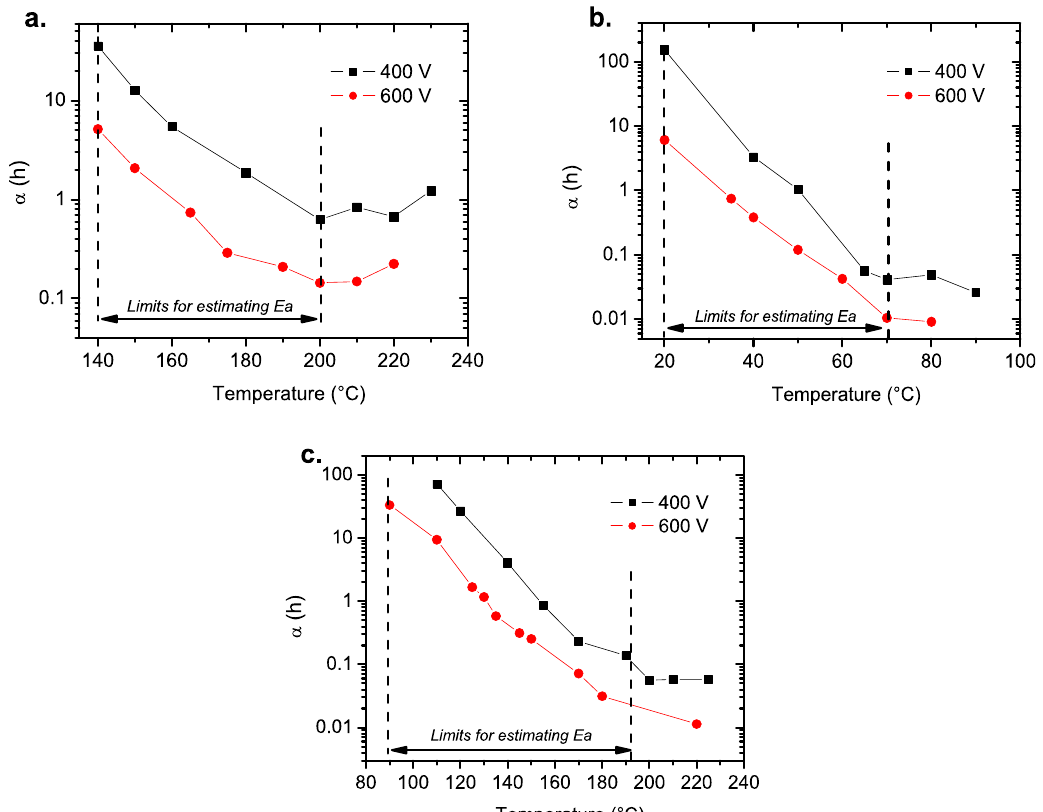
Figure 10. Changes in the scale parameter as a function of the temperature for: ( a ) MLCC-1, ( b ) MLCC-2, and ( c ) MLCC-3. The temperatures delimited by the dashed lines were considered for the Arrhenius plot in the next section.